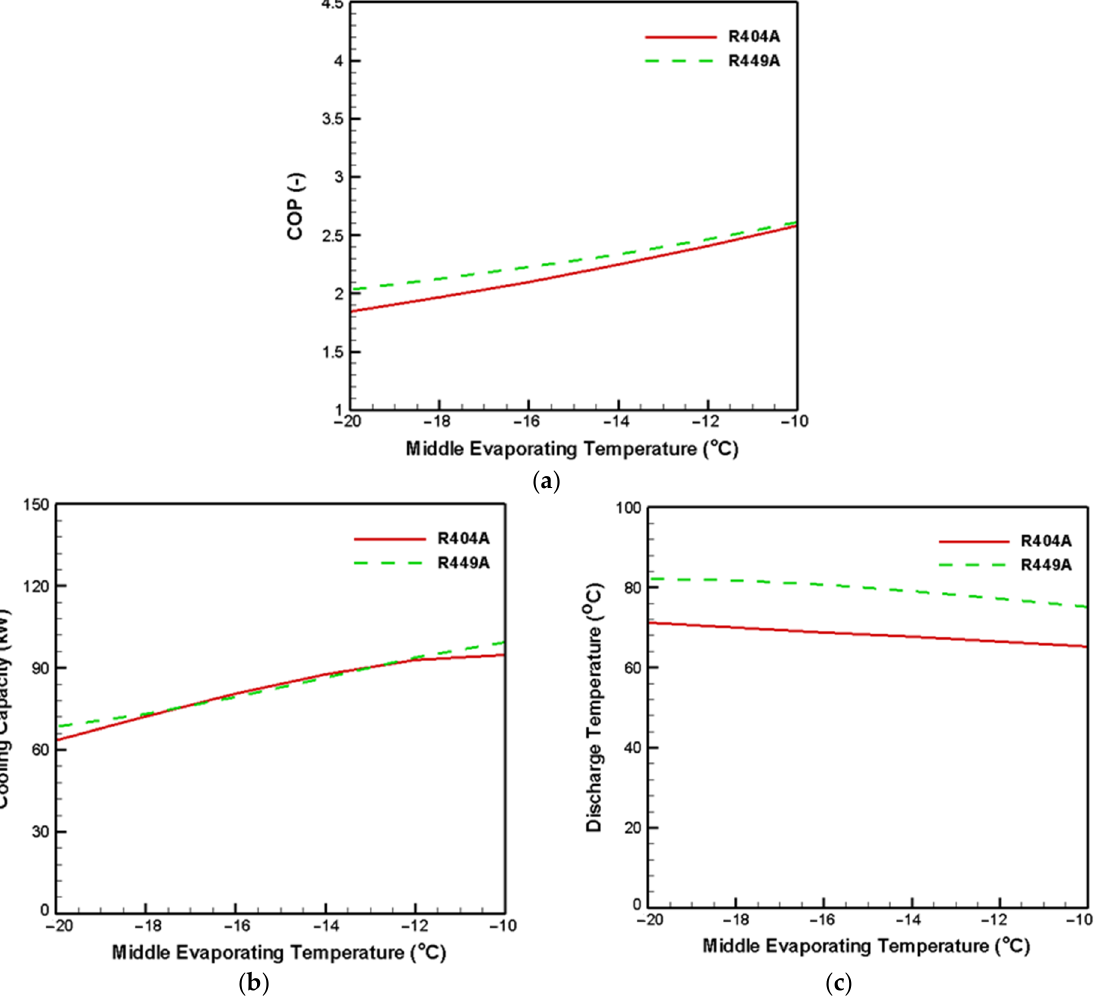
Figure 11. ANN modelling results for ( a ) COP, ( b ) cooling capacity, and ( c ) discharge temperature of the supermarket refrigeration system at MT application.